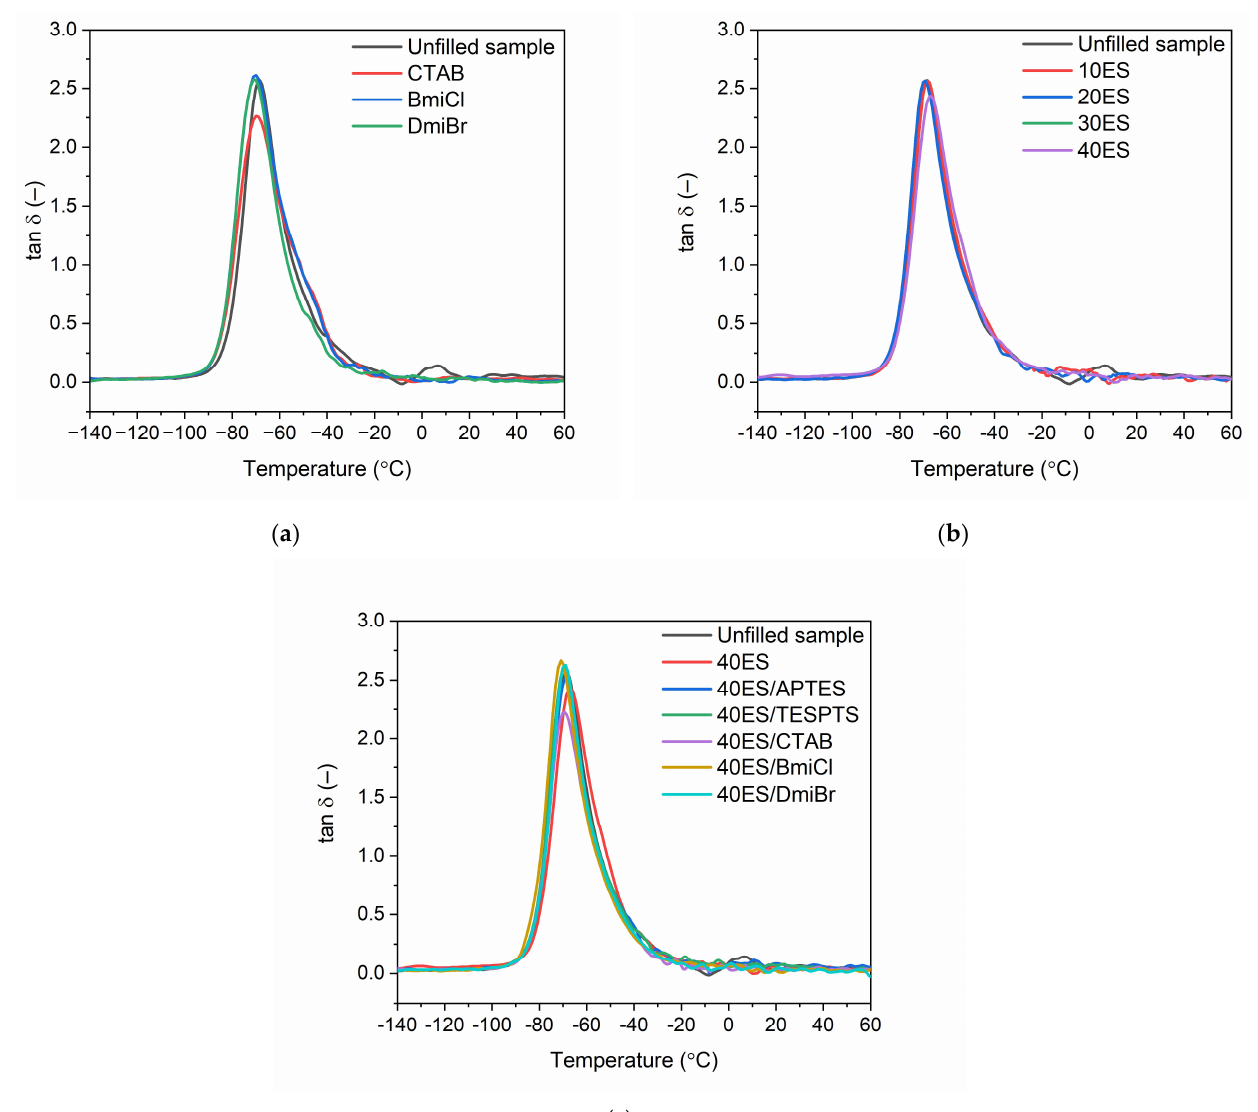
Figure 9. Loss factor (tan δ) curves versus temperature for NR vulcanizates: ( a ) without filler; ( b ) with addition of eggshells; ( c ) with addition of eggshells, silanes, CTAB, and ILs.